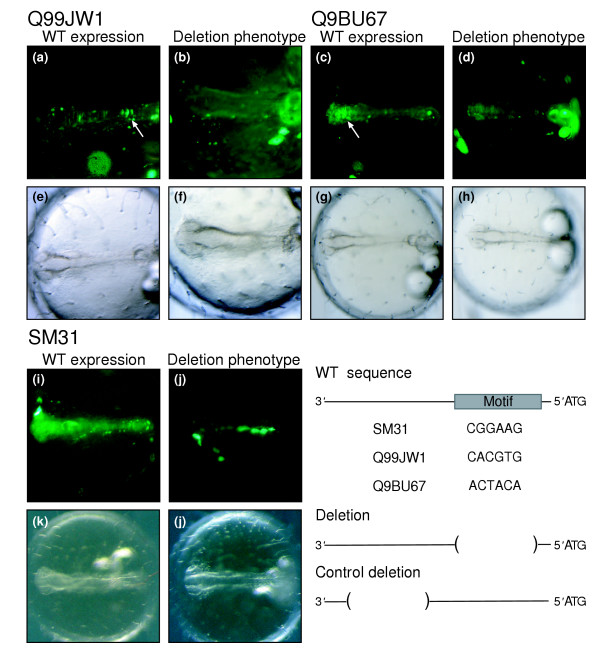
The three deletion mutants. (a-d,i,j) The predominant promoter activity for the indicated constructs, with (e-h,k,l) brightfield images as reference. (a) The arrow points to one of the strong clones, which is visible in many Q99JW1 wild-type (wt) fish compared to (b) the predominant deletion phenotype. (c) Similarly for the Q9BU67 native construct, the arrow in indicates an often found cluster of strong clones, which are hardly found in (d) the deletion construct injected fish. (i) SM31 shows ubiquitous expression found in most embryos injected with the native promoter, whereas (j) depicts the absence of green fluorescent protein expression with the deletion construct. These figures are representative examples from the large set of injections made for each construct (see Materials and methods). (m) Summary of the structure of the constructs used for reporter construction. Besides the native promoter, a construct was created with as precise a deletion of the motif as possible, together with a construct carrying a control deletion in a region presumably devoid of regulatory motifs.